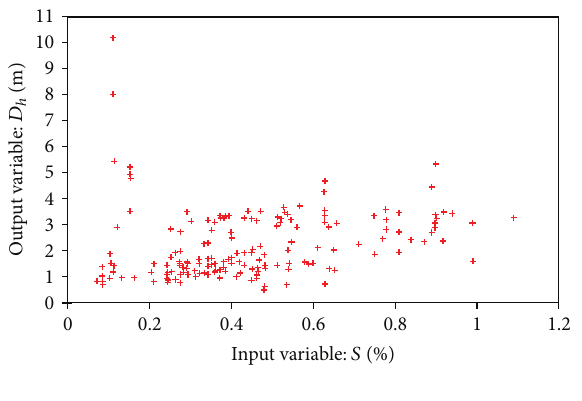
Figure 28: Lateral spreading sample dataset. One input-one output. Figure 29: Clustersand typicals after fuzzy clustering (example with one input-one output).